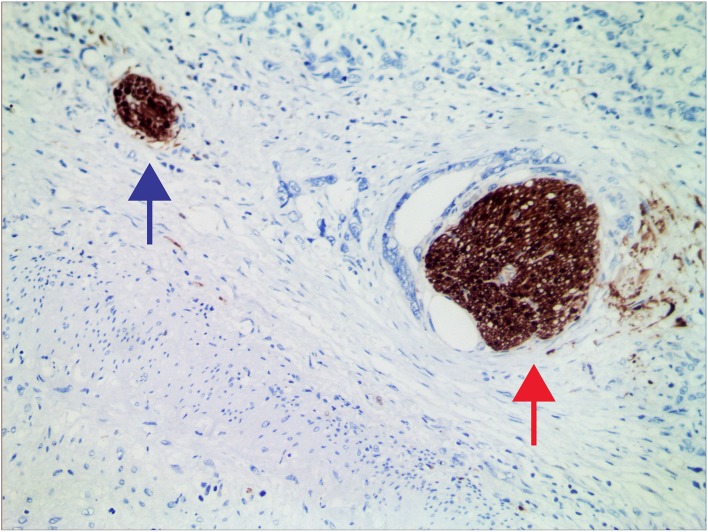
Representative micrographs of nerves invaded (red arrow) and uninvaded (blue arrow) by tumors at 200× magnification.